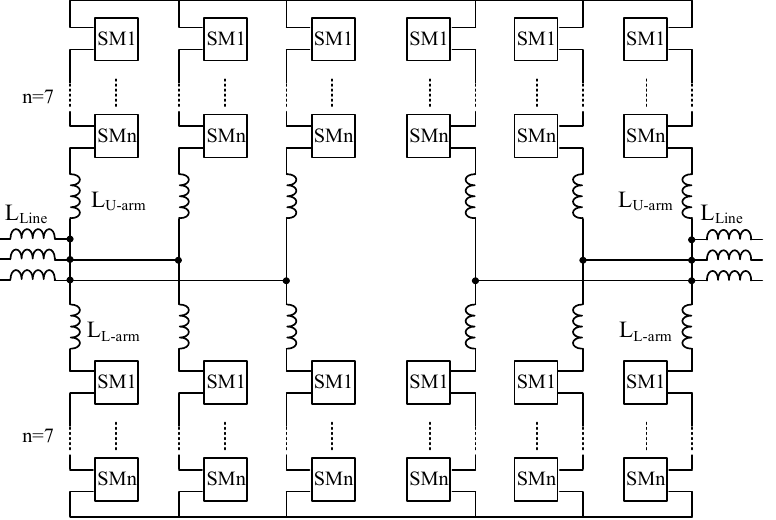
Figure 2. HVDC prototype system circuit.